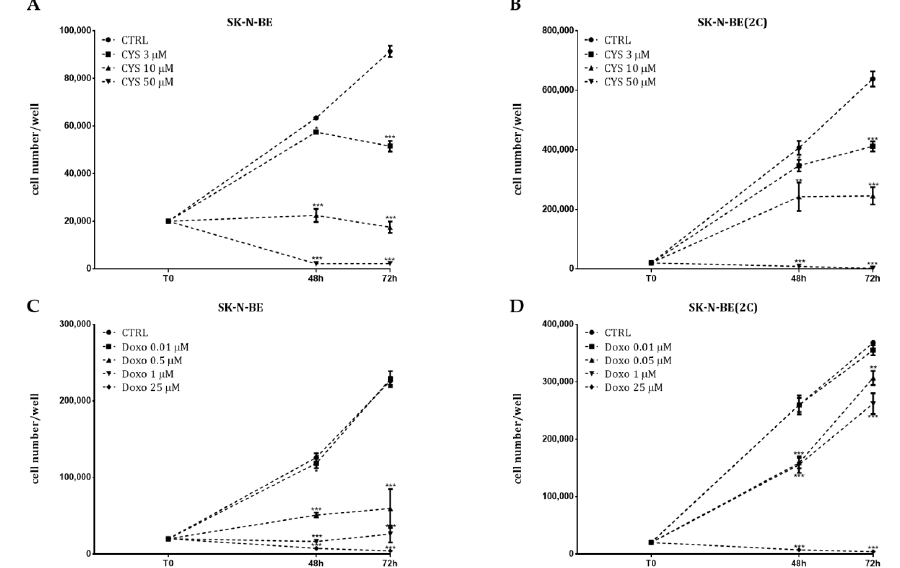
Figure 5. Analysis of cell proliferation by MTT assay after treatment with ( A , B ) cisplatin at